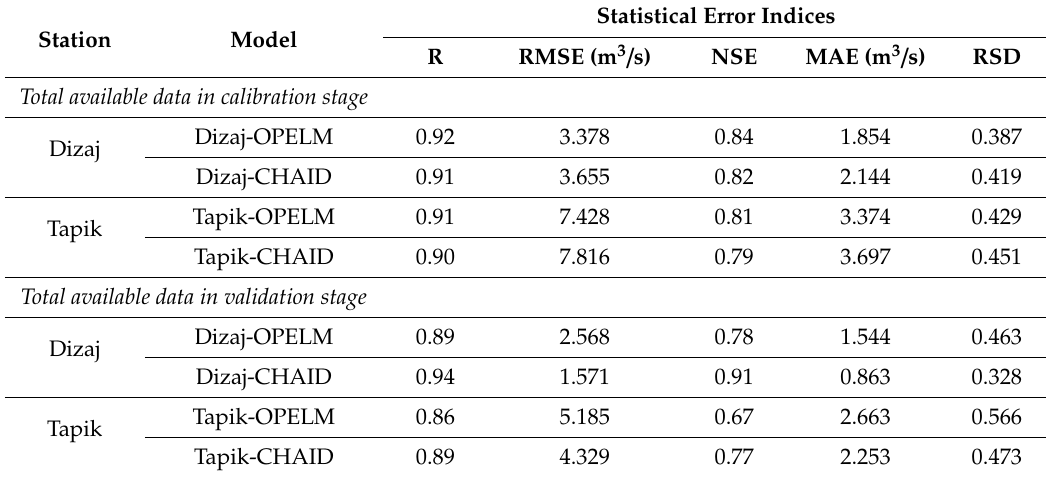
Statistical Error Indices